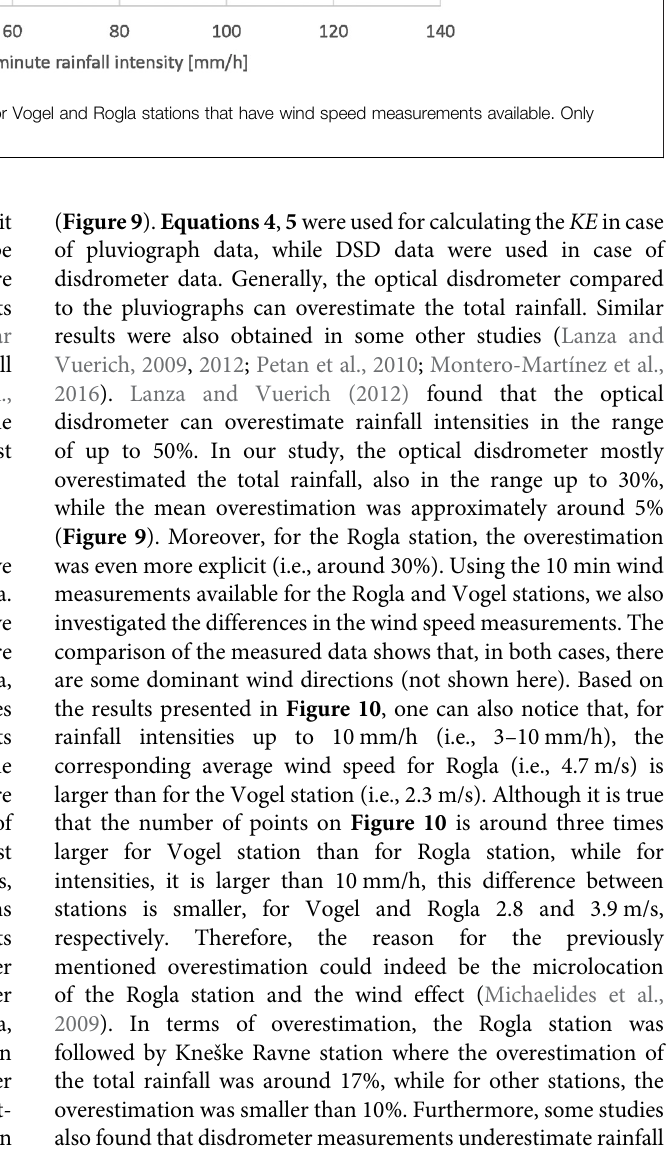
Frontiers in Environmental Science |